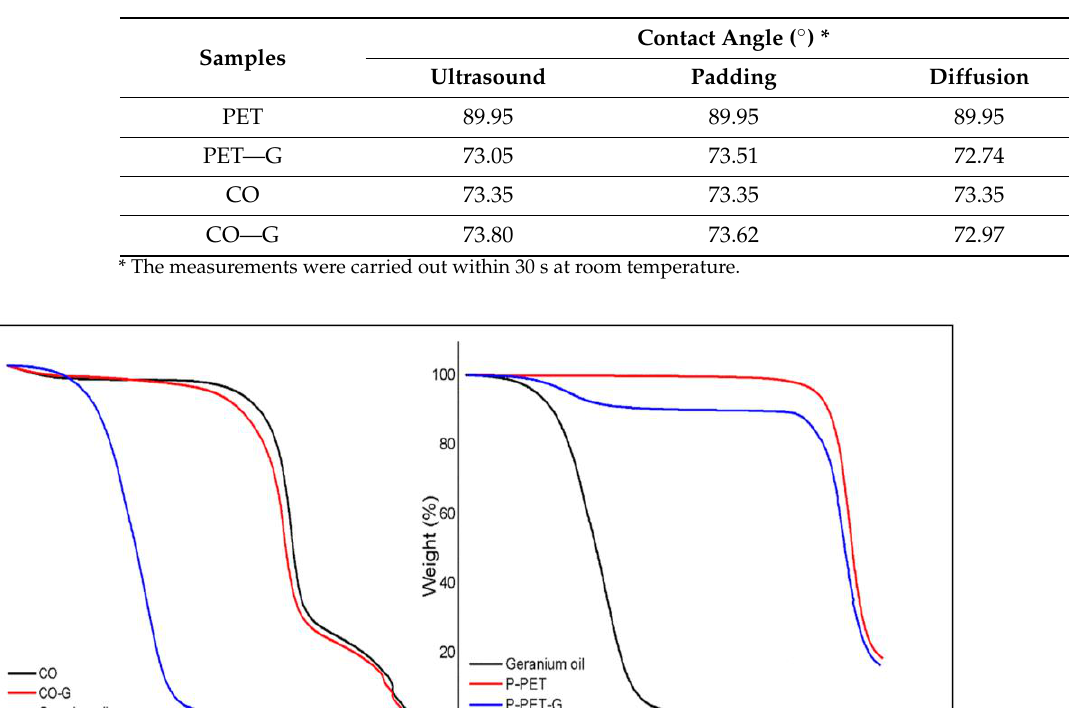
Table 3. Evolution of the contact angle for CO, PET and modified counterparts.